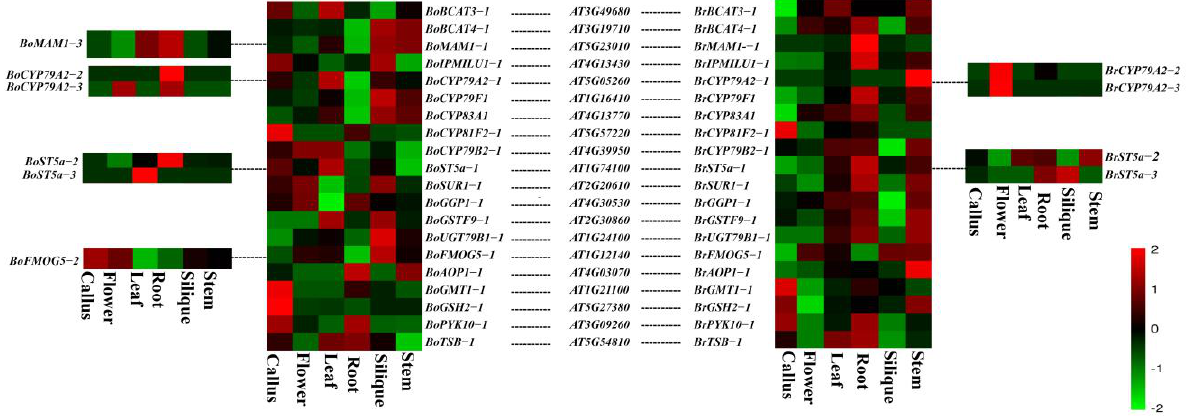
Figure 5. Heat map of homologous gene pairs of glucosinolate biosynthetic genes of Brassica oleracea and Brassica rapa . The color scale bar represents the FPKM value after the log 2 transformation.